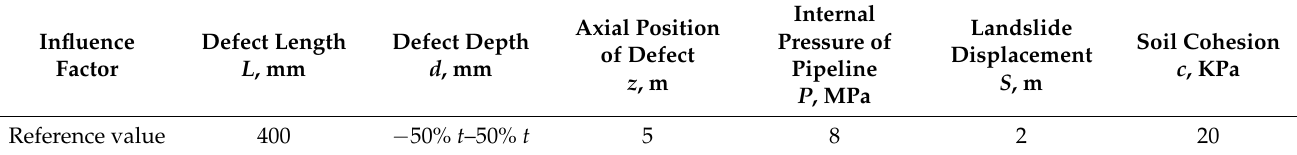
Table 6. Model parameters for varying defect